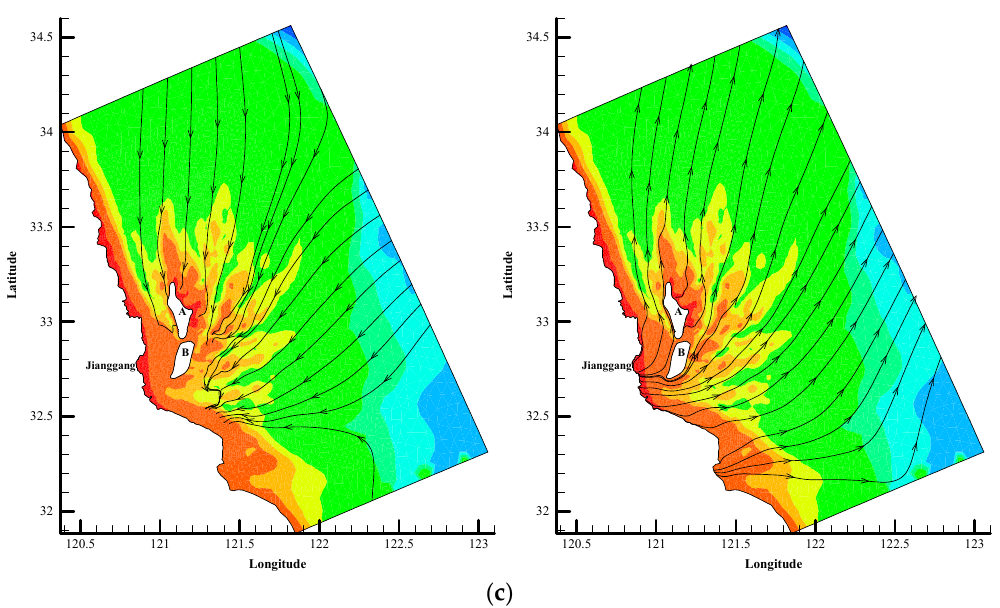
Figure 10. The tidal current streamlines in different topographic conditions (the base map shows the topography); ( a ) Maximum flood and ebb streamlines when the natural RSRs are present; ( b ) Maximum flood and ebb streamlines when there are no RSRs; ( c ) Maximum flood and ebb streamlines when the RSRs are partially reclaimed.